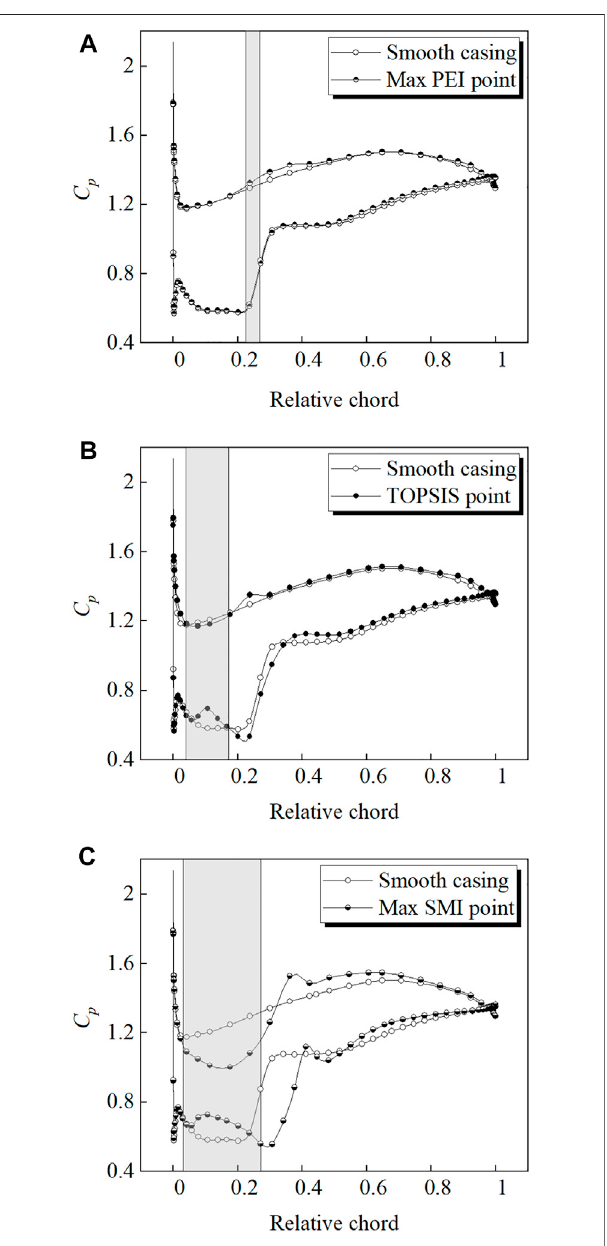
FIGURE 8 | Surface static pressure coef fi cient distribution at 98% span. (A) Max PEI point (B) TOPSIS point (C) Max SMI point.